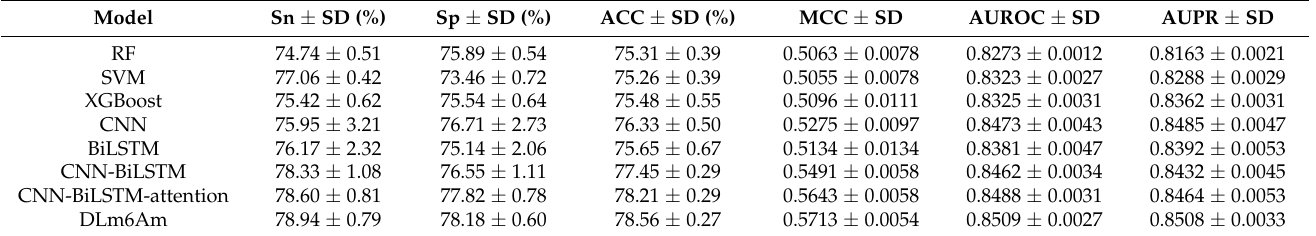
Table 1. Comparison of performance between different model architectures using five-fold cross- validation on training